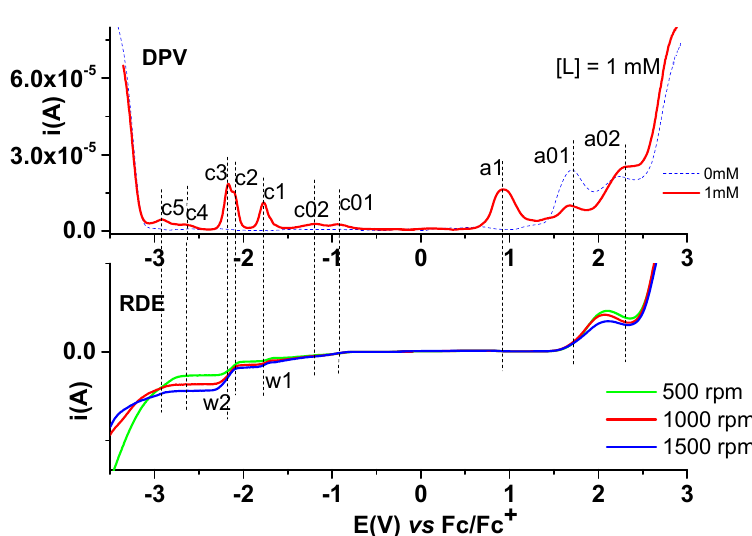
Figure 5. RDE curves at different rotation rates in parallel with the DPV curves (in absolute currents).